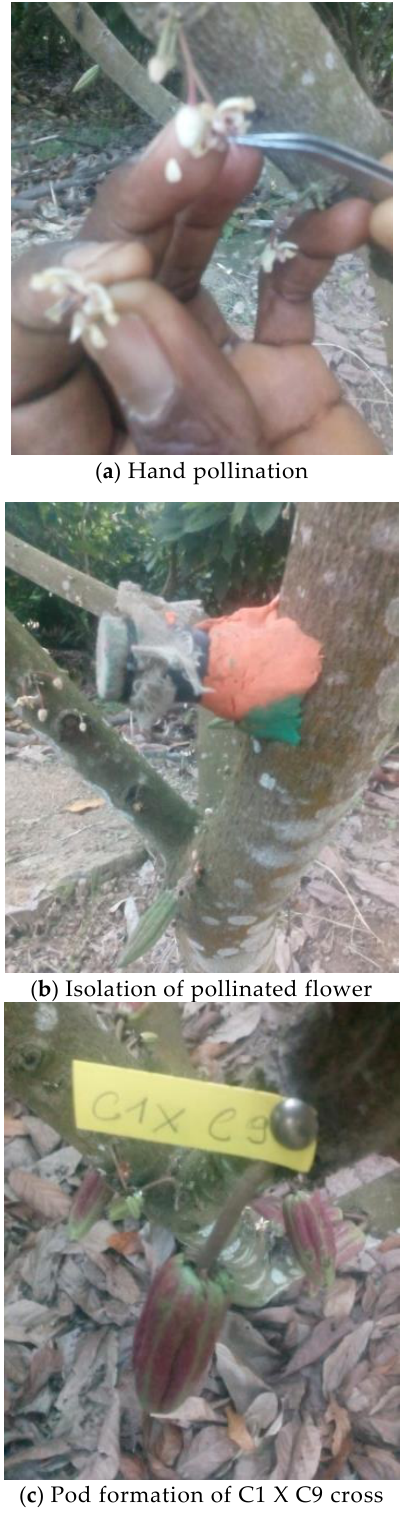
Figure 1. Flower pollination process ( a ) Hand pollination; ( b ) Isolation of pollinated flower ( c ) Pod formation of C1 X C9 cross.